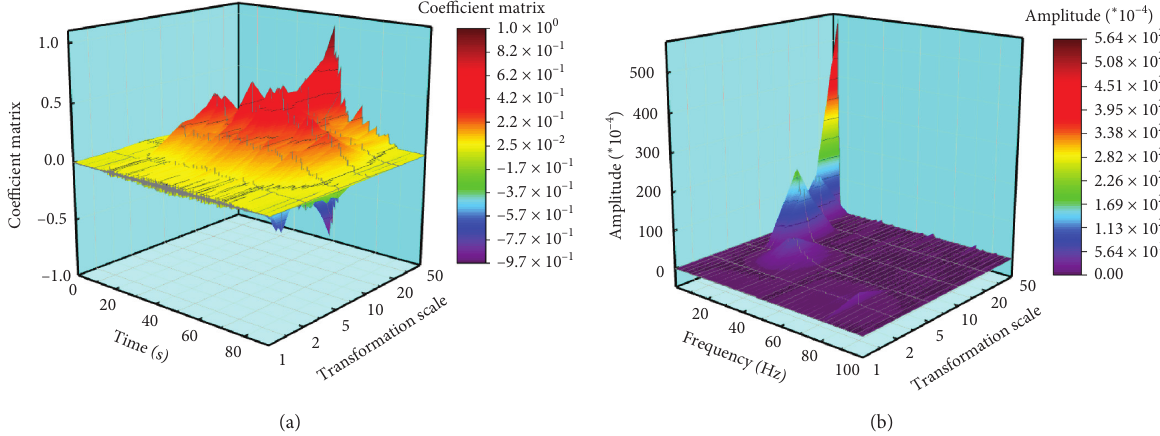
Figure 17: 3D color mapping curve for the crown of the under-crossing tunnel: (a) time-transformation scale-coefficient matrix; (b) frequency-transformation